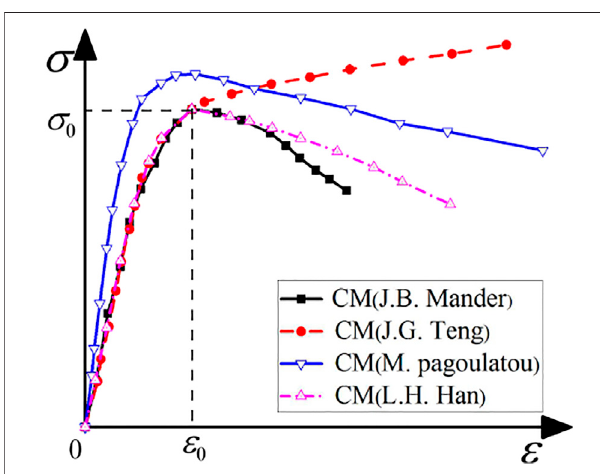
FIGURE 3 | Different constitutive models of concrete.